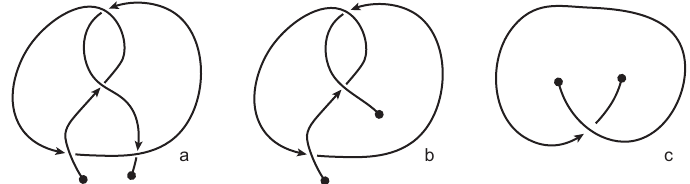
Figure 1. Various types of knotoids. A knot-type knotoid ( a ); a proper knotoid ( b ); and a non-trivial planar knotoid ( c